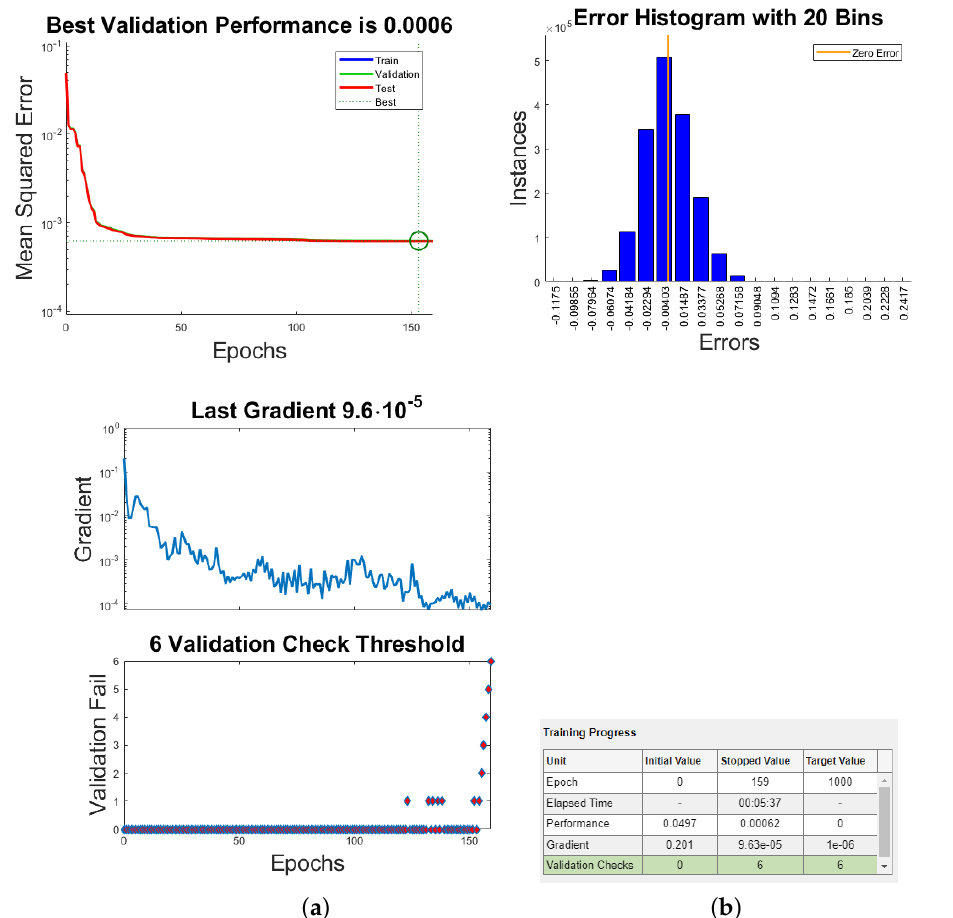
Figure 11. ( a ) Snapshot of Network Training. ( b ) Training Parameters